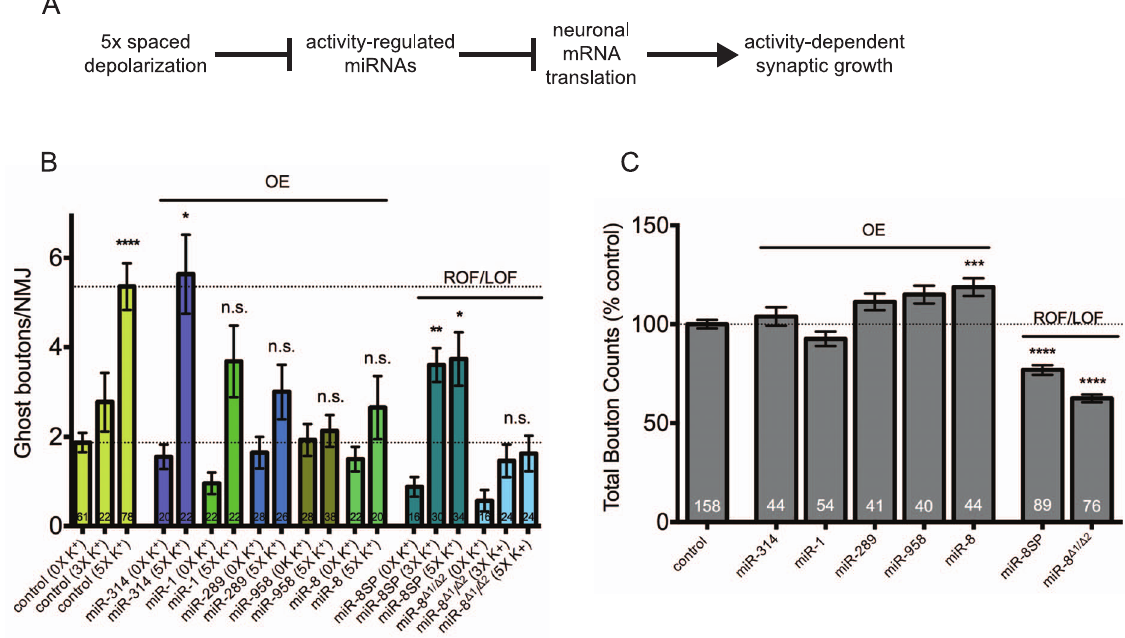
Figure 4. miRs-8, -289, and -958 are required for activity-dependent ghost bouton formation at the larval NMJ. (A) Our working model for miRNA-mediated control of activity-dependent synaptic growth at the larval NMJ. In an unstimulated motor neuron, key activity-regulated miRNAs negatively regulate the expression of target mRNAs involved in the control of activity-dependent synaptic growth. In contrast, our data suggests that acute spaced stimulation results in the rapid downregulation of mature miRNA levels. This would result in the increased translation of target mRNAs and subsequent rapid activity-dependent synaptic growth. (B) Transgenic pri-miRNAs for miRs-1, -8, -289, -314, or -958 were misexpressed in larval motor neurons using the C380-Gal4 driver (e.g. genotype C380-Gal4/ + ; UAS-pri-miR/ + ). Also examined were miR-8 knockdown ( C380-Gal4/ + ; UAS-miR-8SP/ + ) or loss-of-function ( mir-8 D 1 / D 2 ) lines. Ghost boutons per NMJ were quantified in indicated genotypes under conditions of mock (0x), intermediate (3x) or high (5x) K + stimulation as indicated. Compared to their matched 0x unstimulated controls, the misexpression of miRs-8, -289, and -958 did not result in a significant increase in ghost bouton numbers following 5x high K + stimulation. In contrast, miR-8 knockdown ( UAS-miR-8SP ) and deletion ( mir-8 D 1 / D 2 ) larvae showed an enhanced ability to respond to intermediate stimulation. (C) Quantification of the combined number of synaptic boutons (stimulated and unstimulated) at the same NMJs assayed in (B). No significant difference in total bouton number was observed between unstimulated and stimulated NMJ within any miRNA genotype (data not shown). Note that only miR-8 has a significant effect on total bouton numbers when compared to controls ( C380-Gal4/ + ). This suggests that miR-8 has a function in both ghost bouton maturation and development. (B-C) OE=overexpression; ROF=reduction-in-function; LOF=loss-of-function. The numbers located at the bottom of each column indicate the number of NMJs analyzed for each genotype and/or treatment group. Except in C380-Gal4/ + there are 2 paired NMJs per treatment group. Error bars indicate the mean 6 SEM. (B-C) STATISTICS: Kruskal-Wallis multiple comparison analysis with a Dunn’s post-hoc test. n.s.=not significant * p , 0.05 ** p , 0.01 *** p , 0.001 **** p , 0.0001.